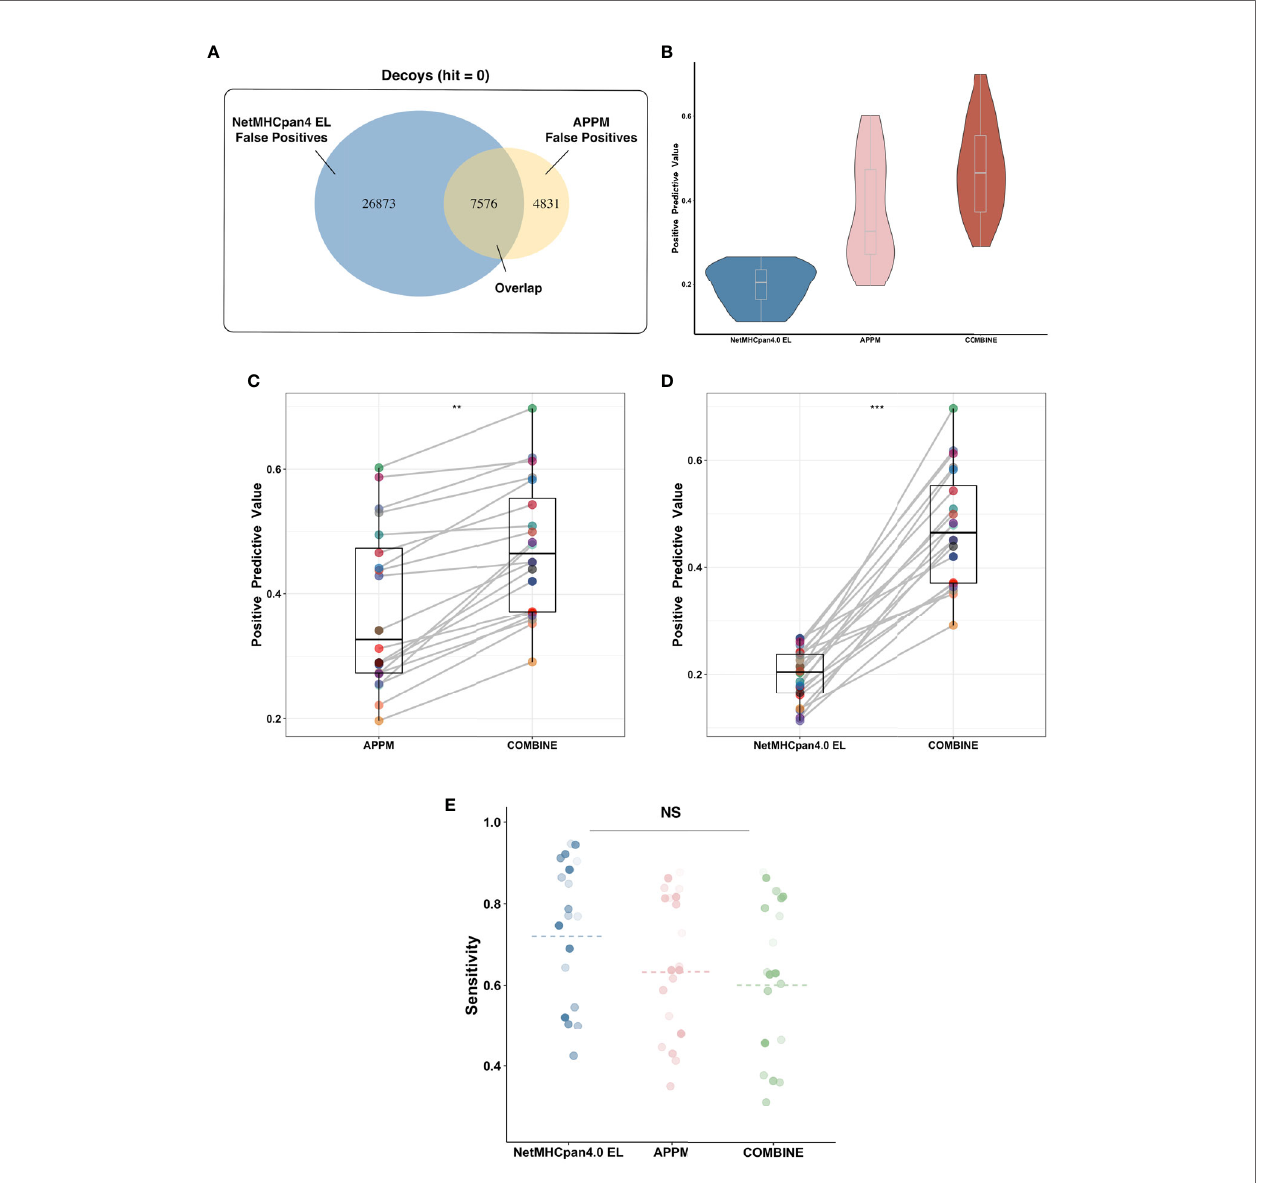
FIGURE 3 | Algorithms Combination Improves Prediction Performance. (A) The false-positive peptides of APPM and NetMHCpan4 EL. These peptides are decoy peptides of mono-allelic MS benchmarks that are incorrectly predicted to be bindings. (B) The mean PPV accuracy on the mono-allelic MS benchmarks for APPM, NetMHCpan4 EL and combination. (C) The signi fi cant improvement of predictive performance in the term of PPV on the mono-allelic MS benchmarks. The left is APPM and the right is the combination of APPM and NetMHCpan4 EL. **p < 0.05. (D) The signi fi cant improvement of predictive performance in the term of PPV on the mono-allelic MS benchmarks. The left is NetMHCpan4 EL and the right is the combination of APPM and NetMHCpan4 EL. ***p < 0.01. (E) The mean sensitivity on the mono-allelic MS benchmarks for APPM, NetMHCpan4 EL and combination. NS, no signi fi